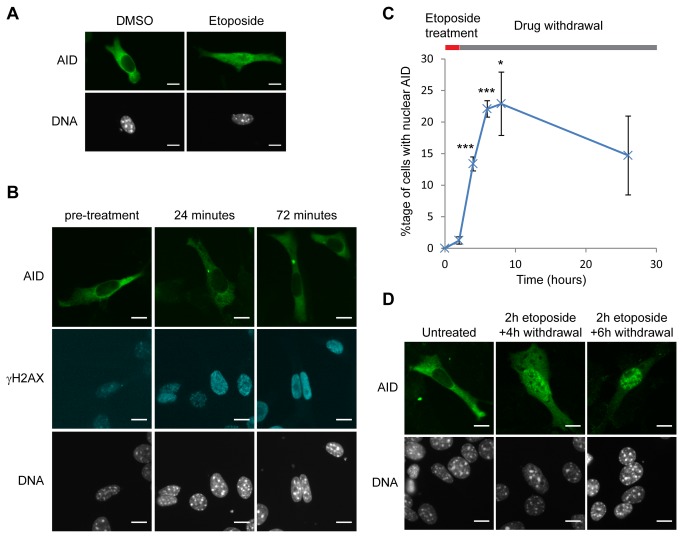
Etoposide induces AID re-localisation.A) AID localisation in NIH/3T3 cells transiently transfected with FLAG-AID and treated for 2 hours with 200µM etoposide or vehicle control (DMSO). Most etoposide-treated cells were indistinguishable from controls, however, the rare cells shown with nuclear AID (<1% transfected cells) in the drug treated sample were never observed in the controls. B) AID distribution after 24 and 72 minutes treatment with 200µM etoposide compared to γH2AX formation. Images were captured at equivalent exposure times to allow visual comparison of signal intensity. C) Percentage of transfected cells showing nuclear AID localisation after 2 hours treatment with 200µM etoposide followed by drug withdrawal for 0, 2, 4, 6 and 24 hours. Data is from three independent experiments, two using FLAG-AID and one using GFP-AID constructs to ensure that the specific tag was not the source of the effect. Error bars represent ±1 s.e., *** p<0.01, * p<0.05 for Student’s t-test comparing given time point to pre-treatment (time=0). D) AID localisation after 2 hours etoposide treatment followed by 4 and 6 hours drug withdrawal. Scale bars at bottom right of each image indicate 10µm.